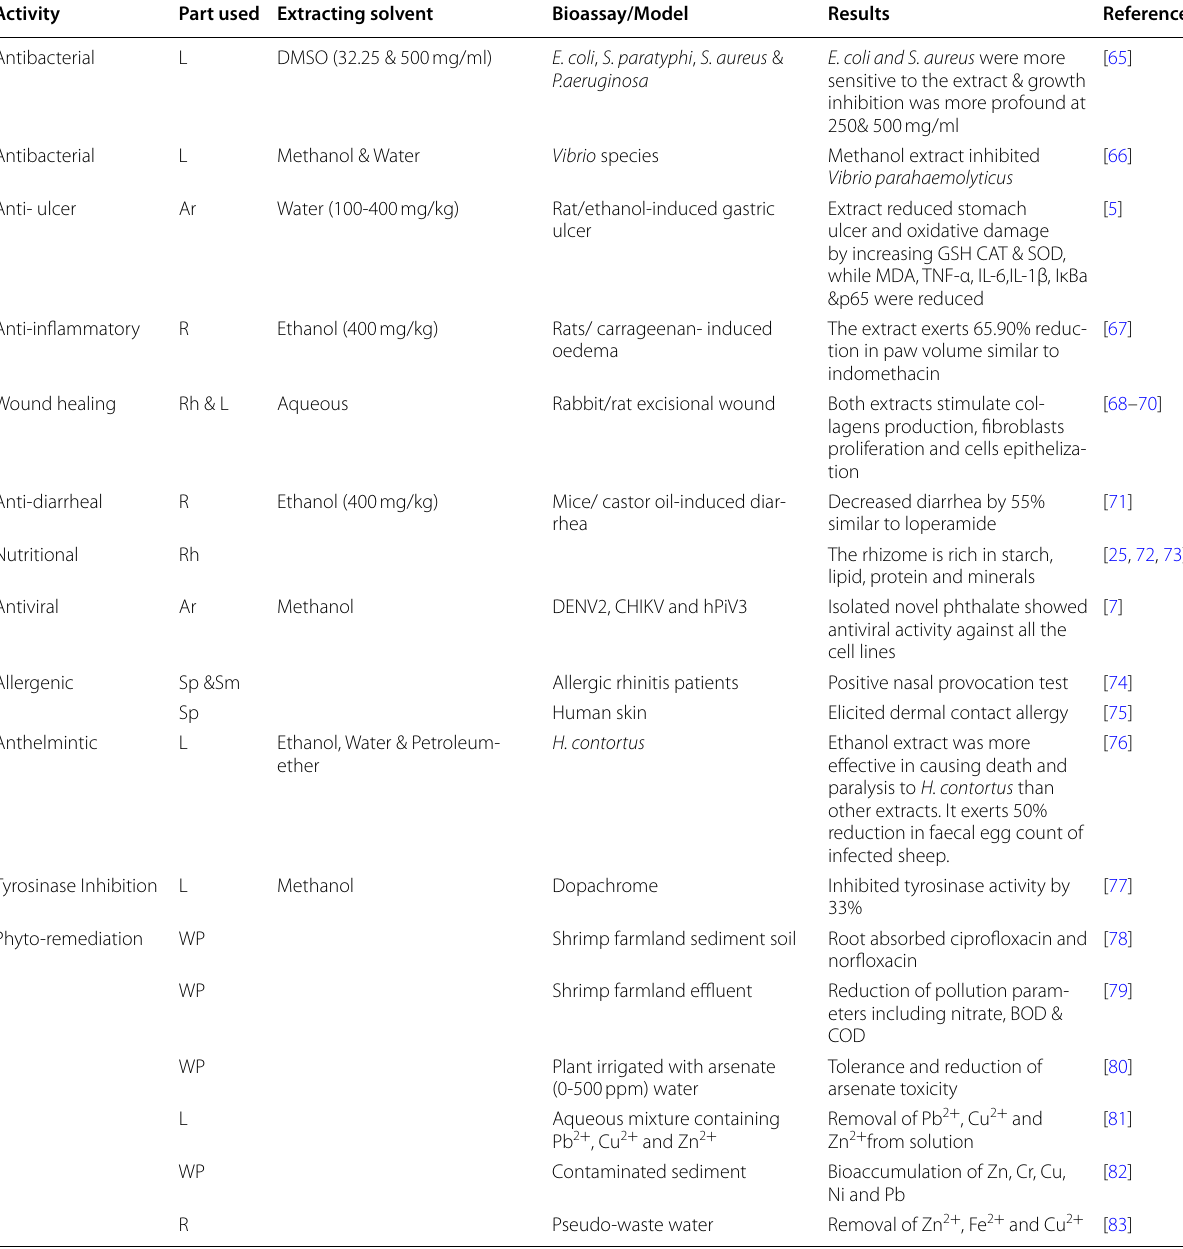
Key: L Leaves, TCL Tumor cell lines, WP Whole plant, HeLa Human cervical cancer cells, F Fronds, R Root, Rh Rhizome, S Stem, Ar Aerial part, T Twig, GSH Glutathione, SOD Superoxide dismutase, CAT Catalase, MDA Malondialdehyde, TNF-α Tumor necrosis factor-α, IL6 Interleukin-6, IL-1β Interleukin-1β, DENV2 Dengue virus, CHIKV Chikungunya, hPiV3 Human parainfluenza virus type 3, Sp Spores, Sm Sporangial matter, GAE Gallic acid equivalent, QE Quercetin equivalent, B Benzene, TPC Total phenolic